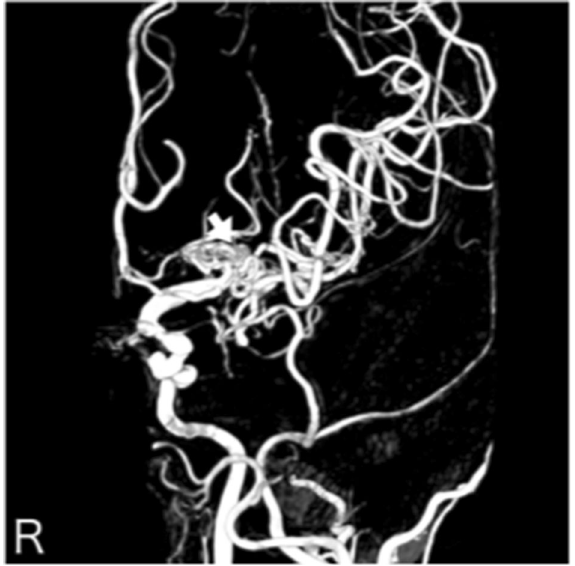
Figure 2. Anterior posterior view of three-dimensional digital subtraction left internal carotid angiographical findings in patient 2 indicating left twig-like middle cerebral artery (white arrow).